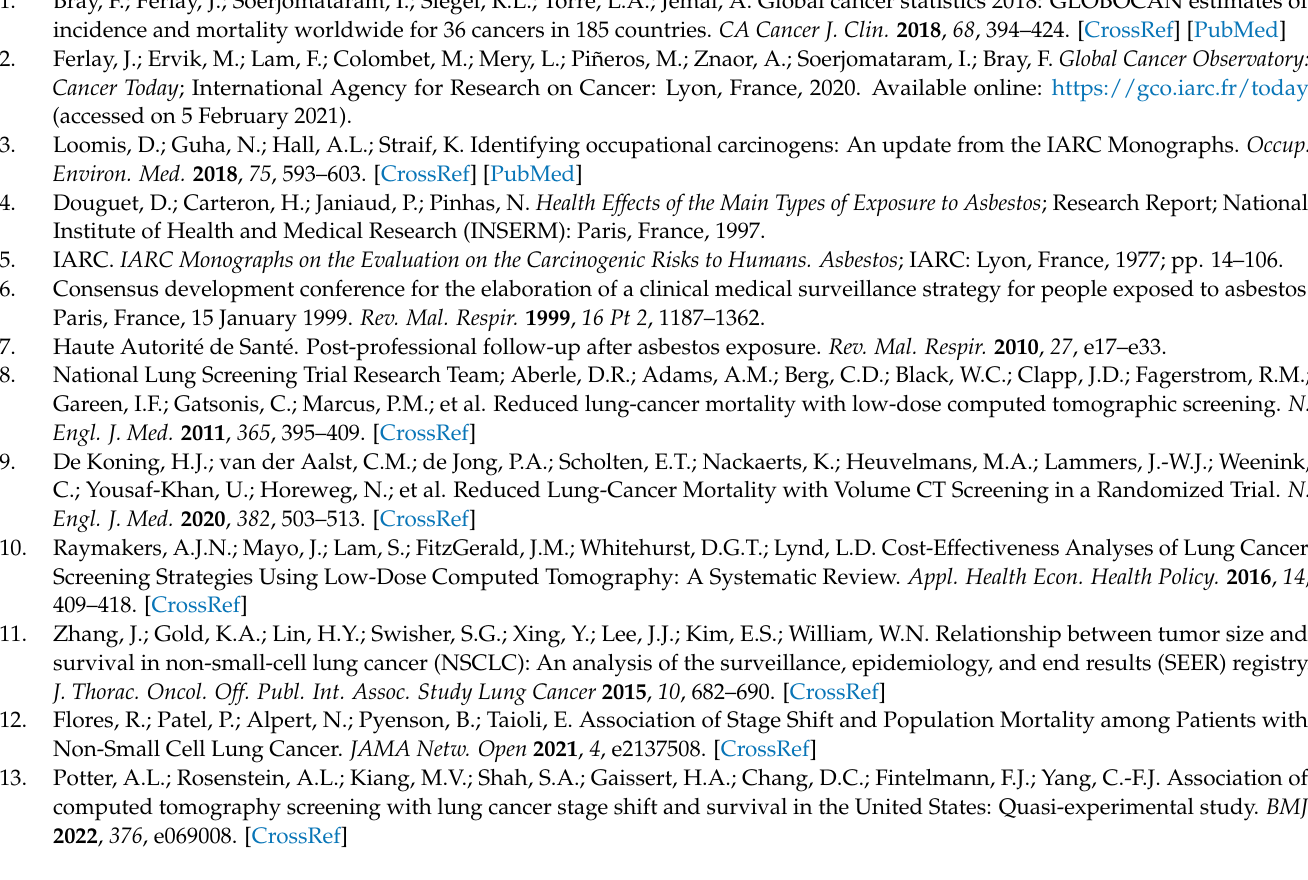
Supplementary Table S2: Costs in Euros of ARDCO Cohort and Individual Non-Intervention-Subject- Initiated Care; Supplementary Table S3: Costs Generated by Lung Cancer Screening and Manage- ment of False-Positive Findings; Supplementary Table S4: Cost-Utility Analysis of the Different Screening